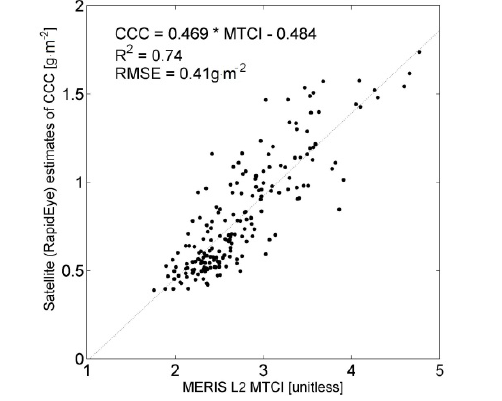
Figure 6. Comparison between MERIS L2 MTCI and CCC [g·m − 2 ] estimated at fine spatial resolution and aggregated at 1 km spatial